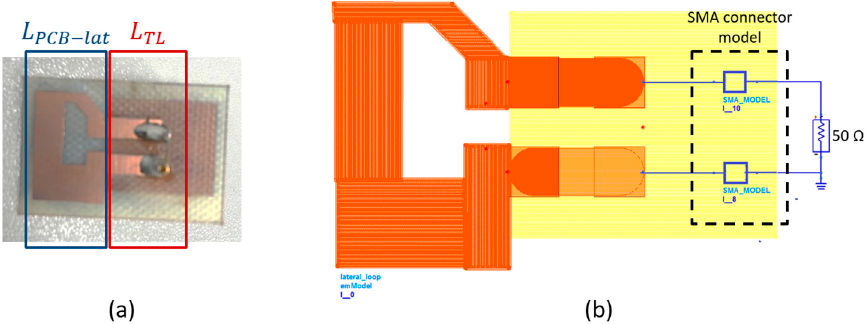
Figure 9. Lateral PCB loop: ( a ) test fixture; ( b ) simulation setup.